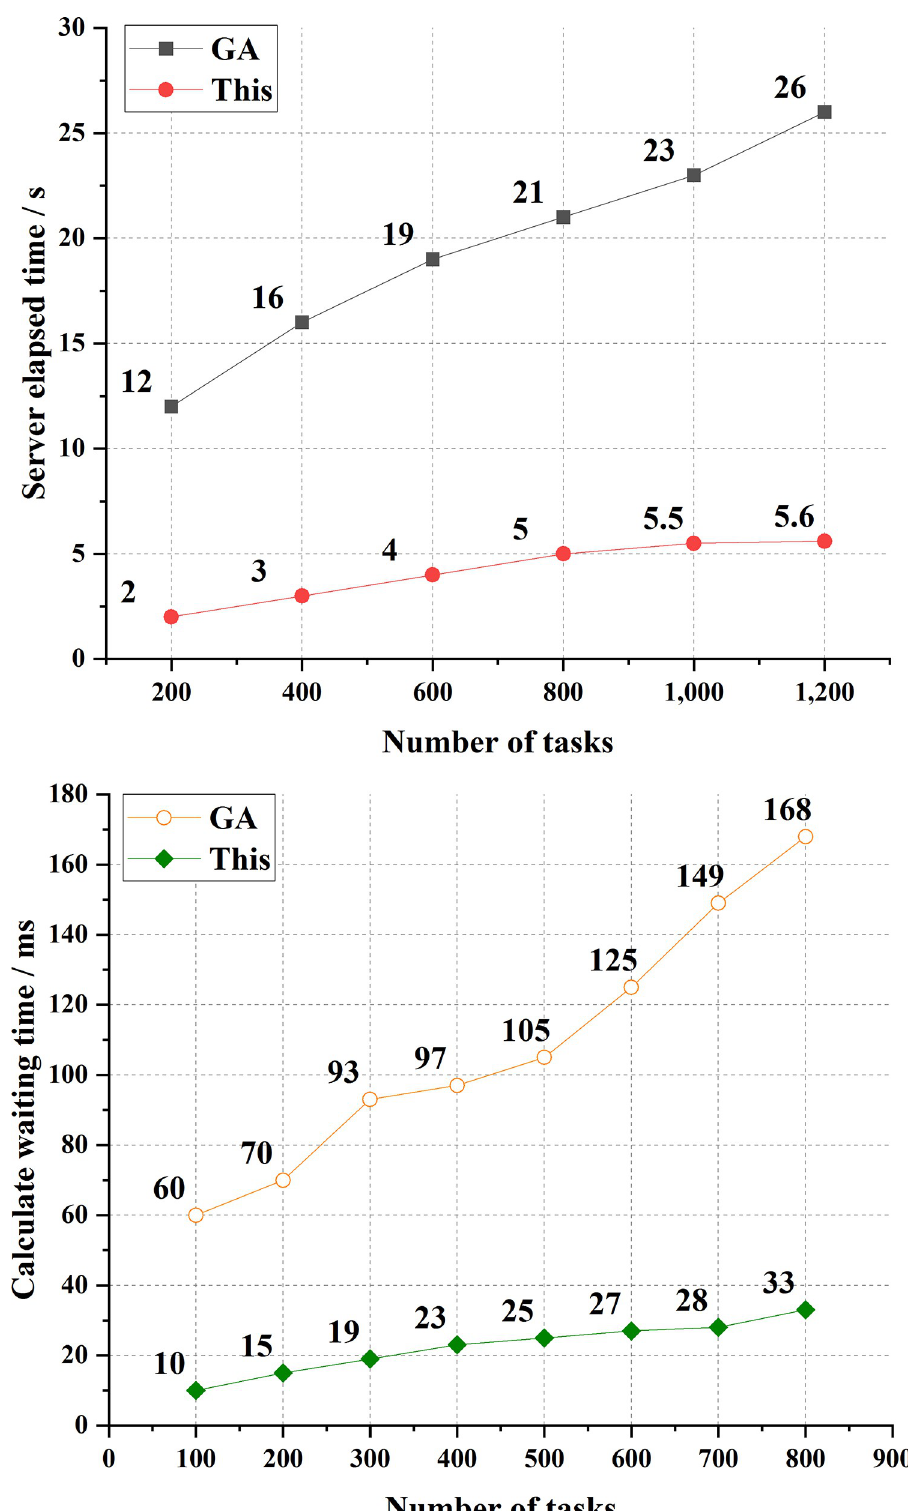
Fig 6. Model performance test results (a. Server occupancy time; b. Calculation waiting time).